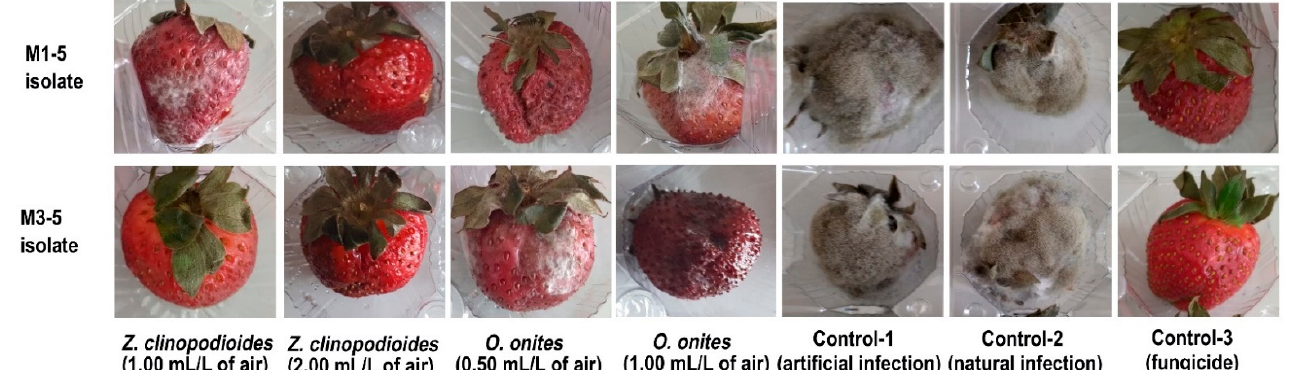
Figure 5. Visual appearance of fruits and disease severity at the 21st day of storage.